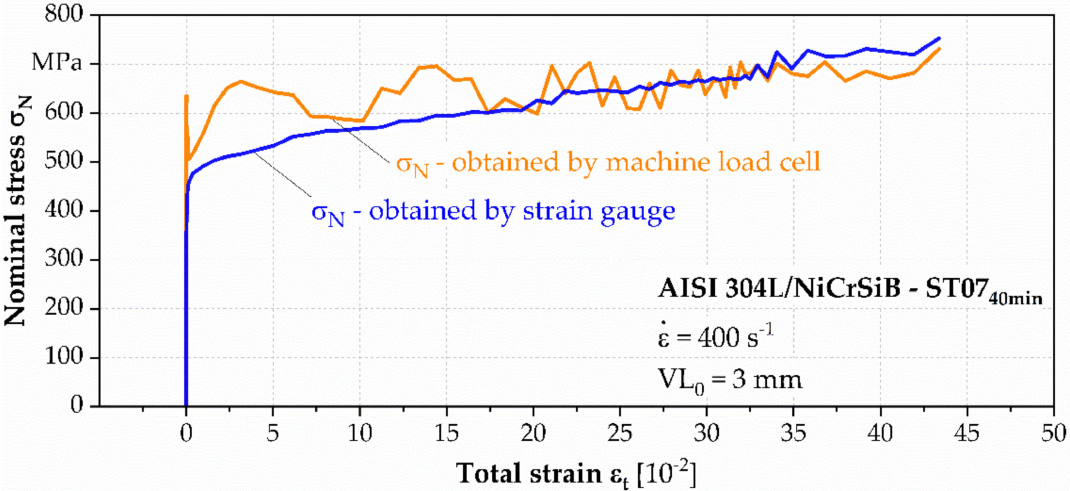
Figure 17. High-strain-rate tensile test with ST07 40min